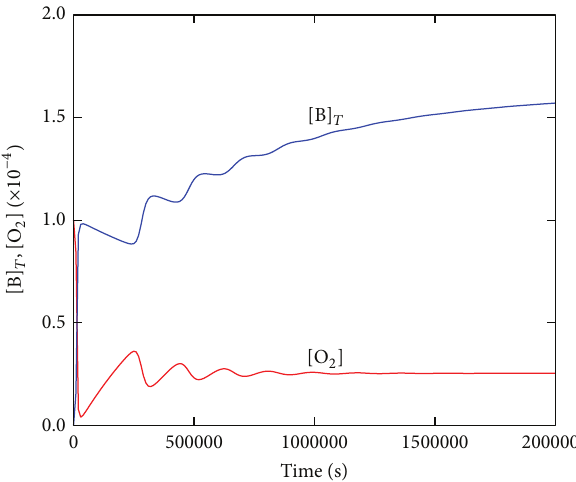
Figure 5: Simulation of EPEC growth behavior in an open-flow bacterial chemostat predicting an oscillatory approach to the steady states of the total bacteria and oxygen concentrations. The same parameters as in Figure 3 (SA/V = 0 .71), flow rate constants 𝑘 5 = = 2 . 0 × 1 0 −6 s −1 ; [ B ] = 4 . 0 × 1 0 −8 , [ O ] = 1 . 0 × 1 0 −4 , and 𝑘 6 0 2 0 = 8 . 0 × 1 0 −3 M, all others at zero. [ N ] 0